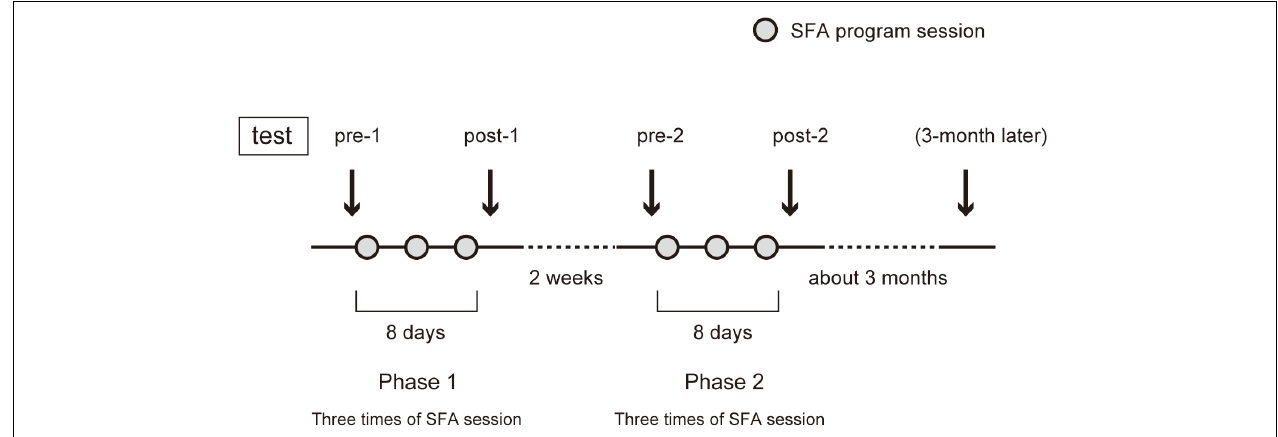
FIGURE 1 | Experiment schedule of the SFA-treated